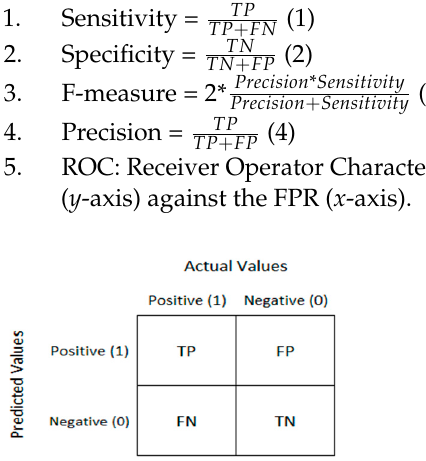
Figure 2. Confusion matrix (Narkhede, 2018)